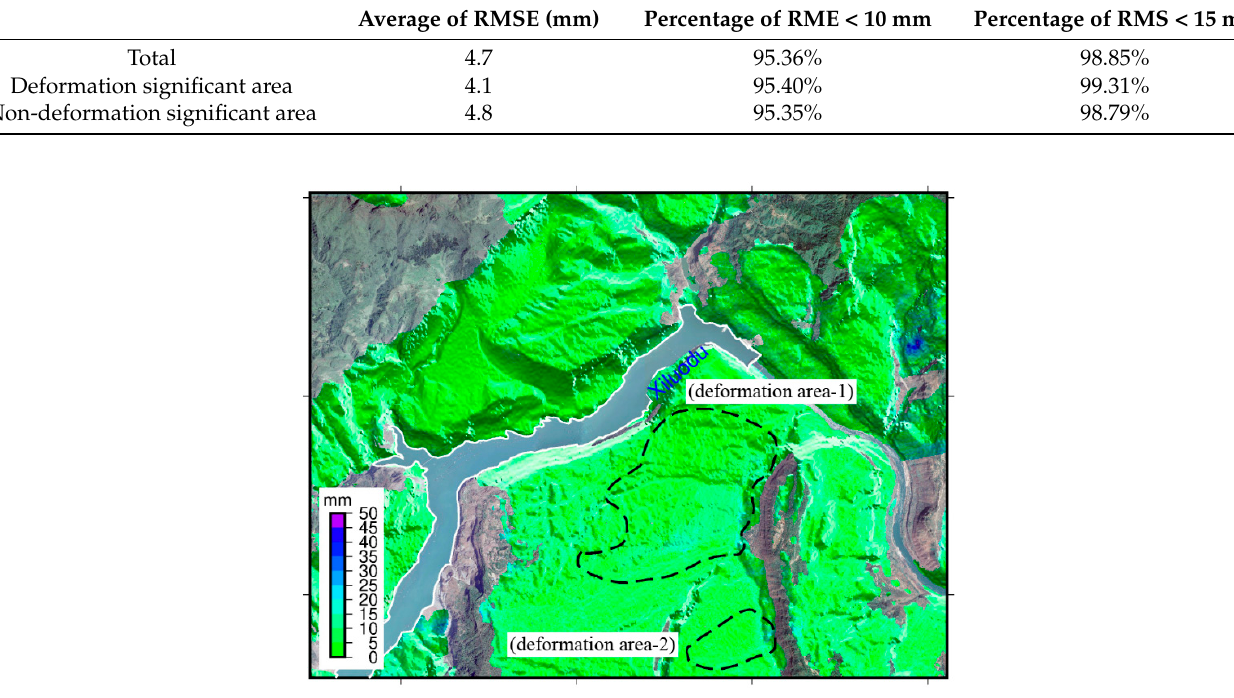
Figure 14. Overall root mean square error